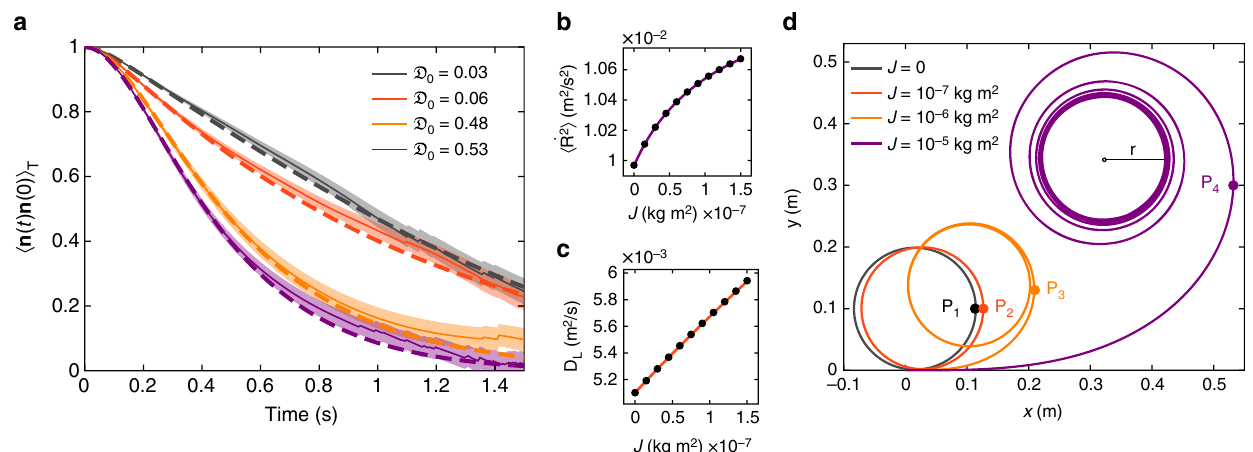
Fig. 5 Particle dynamics dependence on rotational inertial delay. a Time dependence of orientational correlation functions. Solid lines represent the measurements, error bands represent the standard error of the mean. Dashed lines are the analytic results using the parameters from Fig. 3. b Slope of the (cid:3) (cid:4) ballistic regime, i.e. the second moment of the velocity _ R , as a function of J (the circles and solid line are the numerical results and the analytic solution to Eq. (5), respectively). The model parameters (except J ) are those used in Fig. 6. c Long-time diffusion coef fi cient D L as a function of J (the circles and solid line are the numerical results and the analytic solution to Eq. (8), respectively). d Trajectories of active particles under a constant torque applied at t 0 . As J increases the turn-around manoeuvre becomes increasingly dif fi cult, so the distance and time increase until the turning point P 1,2,3,4 is reached